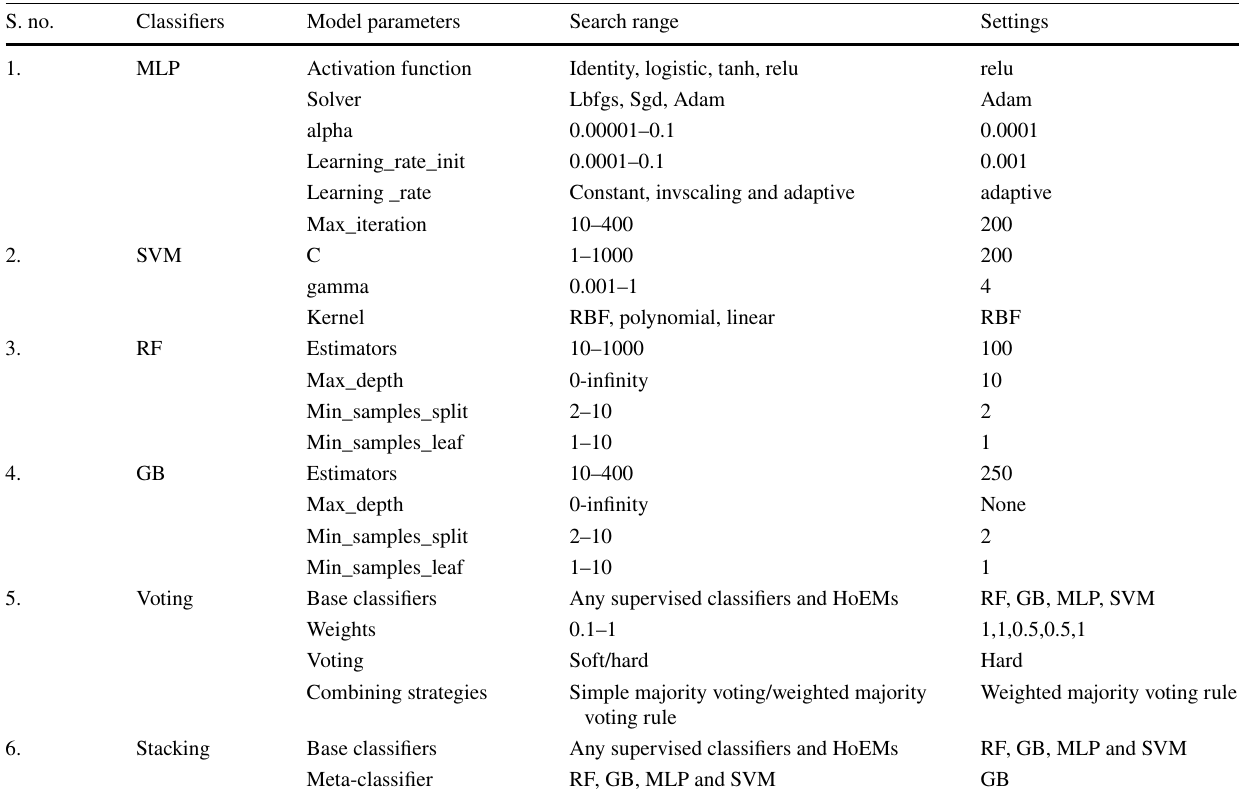
Table 3 The search range and optimized values of model parameters obtained through grid search algorithm on input well logs data S.